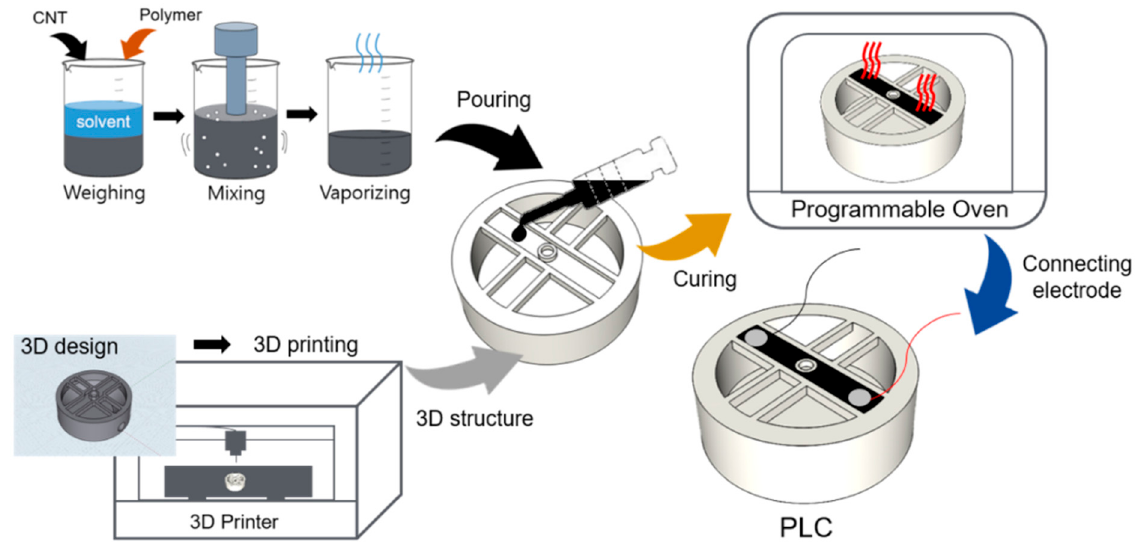
Figure 2. Process to fabricate the printed load cell (PLC) structure and the nanocarbon piezoresistive composite flexure.